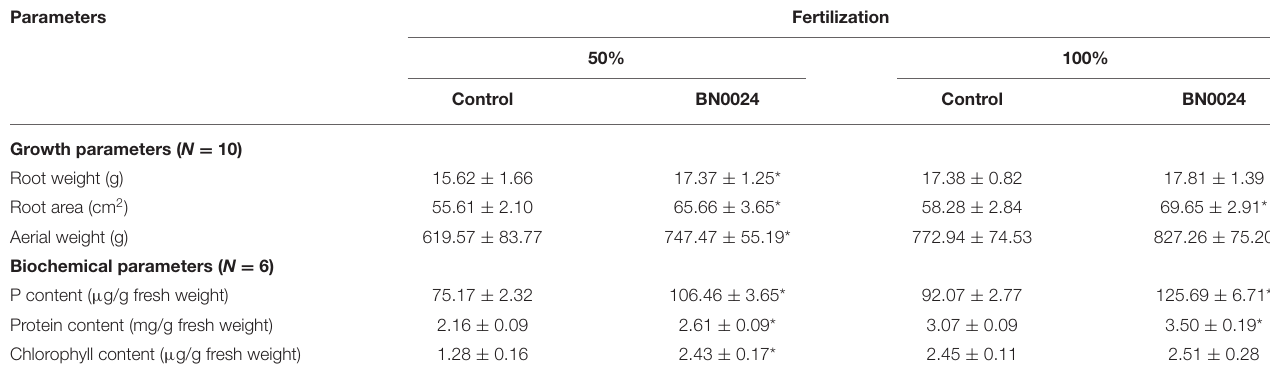
TABLE 4 | Growth parameters from the lettuce field experiment, carried out with two levels of fertilization (50 and 100%) and root application of strain BN0024 at transplant. Parameters Fertilization